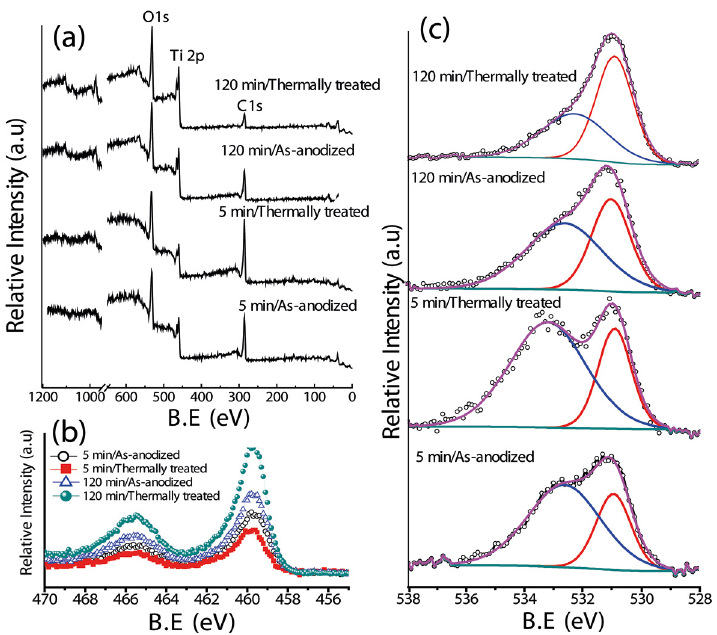
nanotubes; (a) survey 2